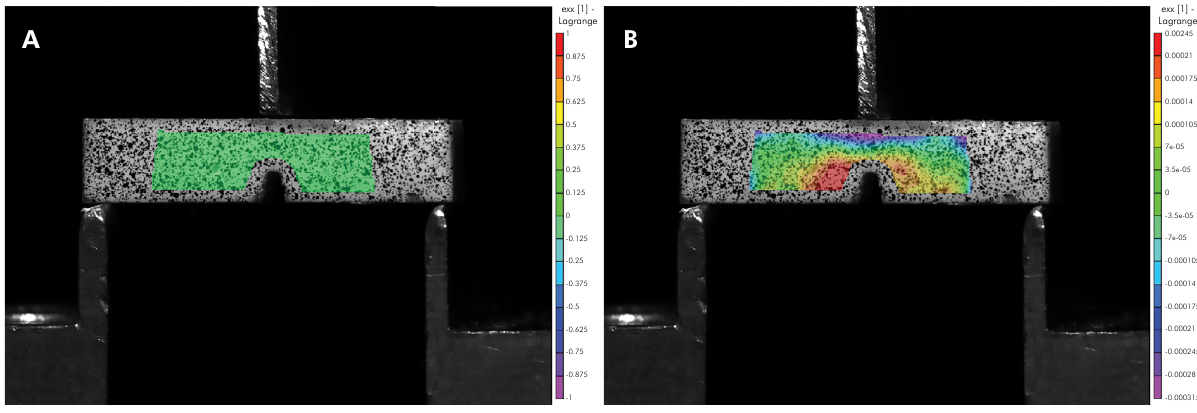
Figure 3. (a) Lithium disilicate glass ceramic represented by neutral strains on moments before initial loading. (b) The compression area can be identified by the negative forces applied at the top of the specimen. The v-notch is characterized by positive tensile spread over it. On both sides of the v-notch yellow orange area is present.